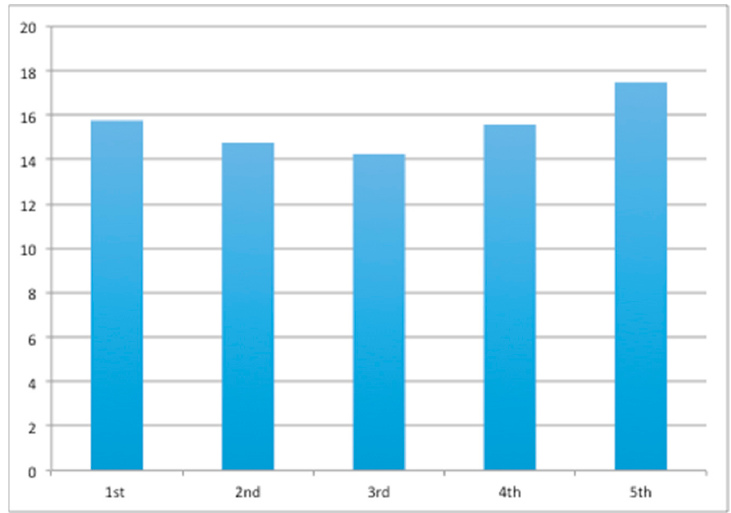
Figure 3. Average time (s) the dogs spent on each toy over testing in phases